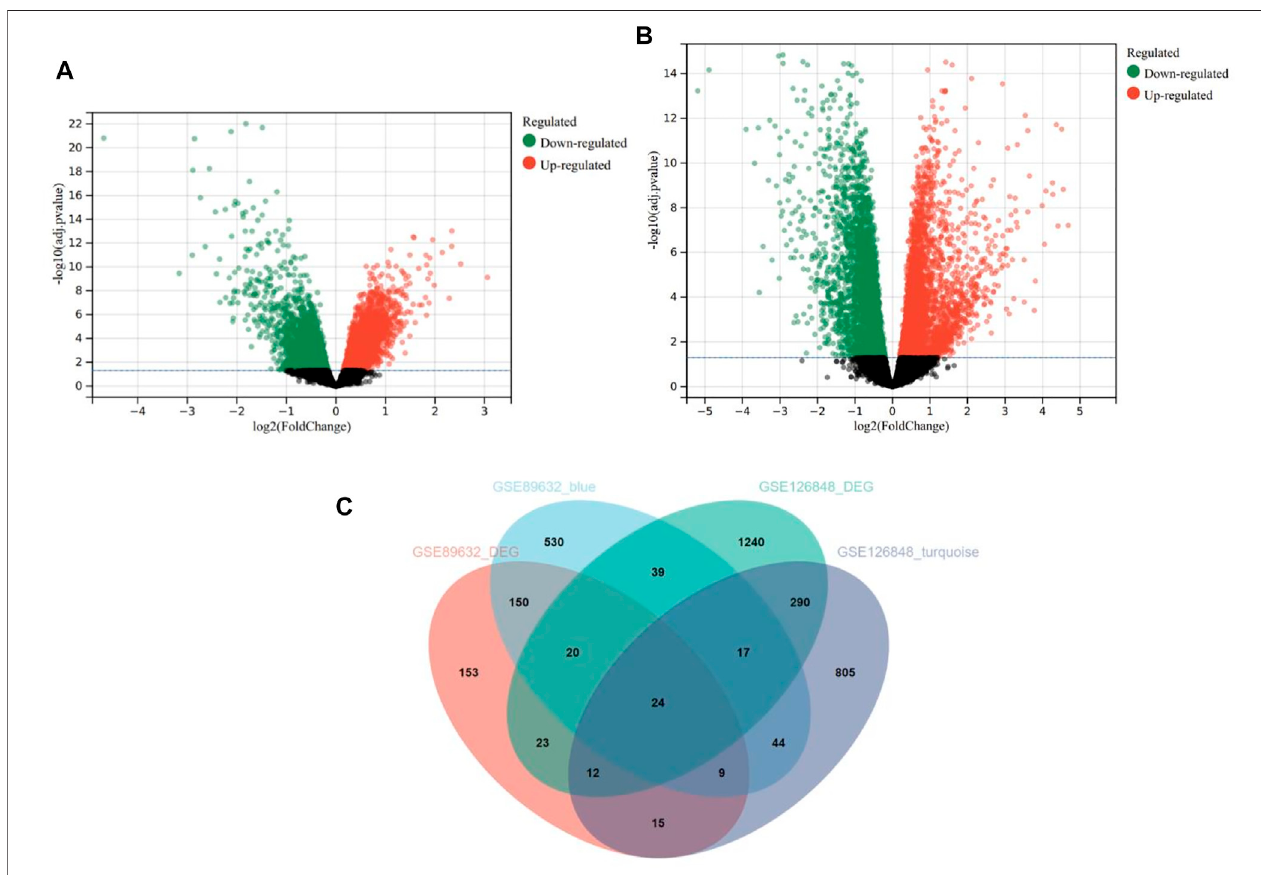
FIGURE 5 | Differentially expressed genes (DEGs) in the GSE89632 and GSE126848 datasets. (A) Volcano plot of DEGs in the GSE89632 dataset. (B) Volcano plot of DEGs in the GSE126848 dataset. (C) The Venn diagram of genes from the DEG lists and co-expression modules.